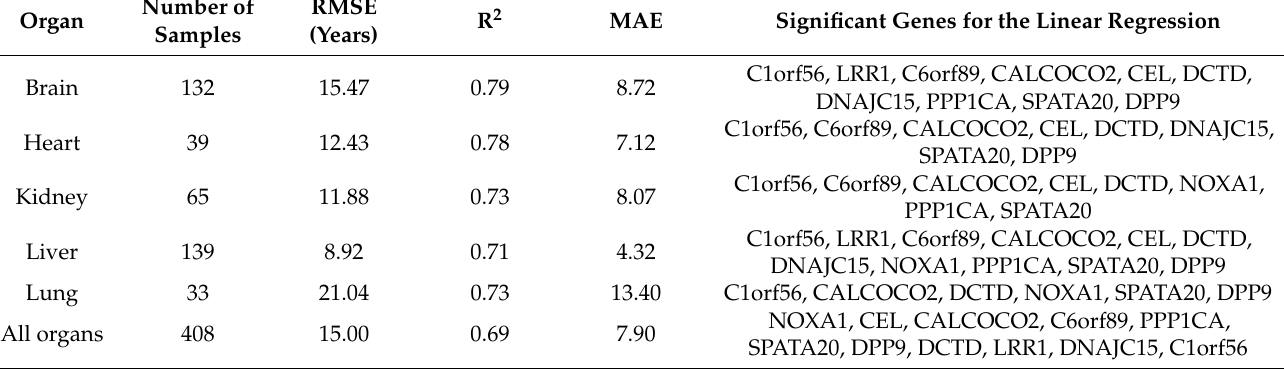
Table 1. Goodness of fit statistics for the multilevel Bayesian linear